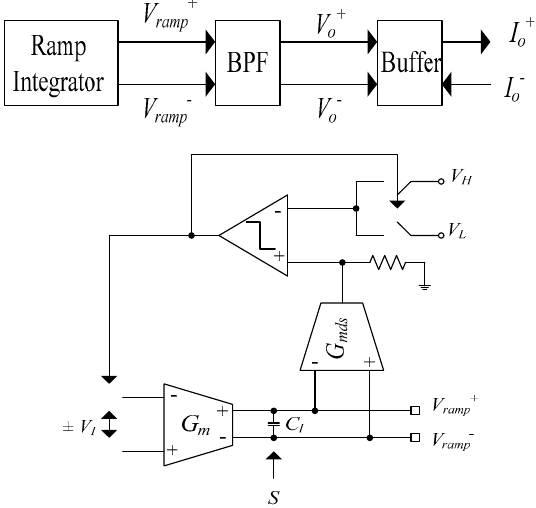
Figure 4. Block diagram of current driver and ramp generator [10].